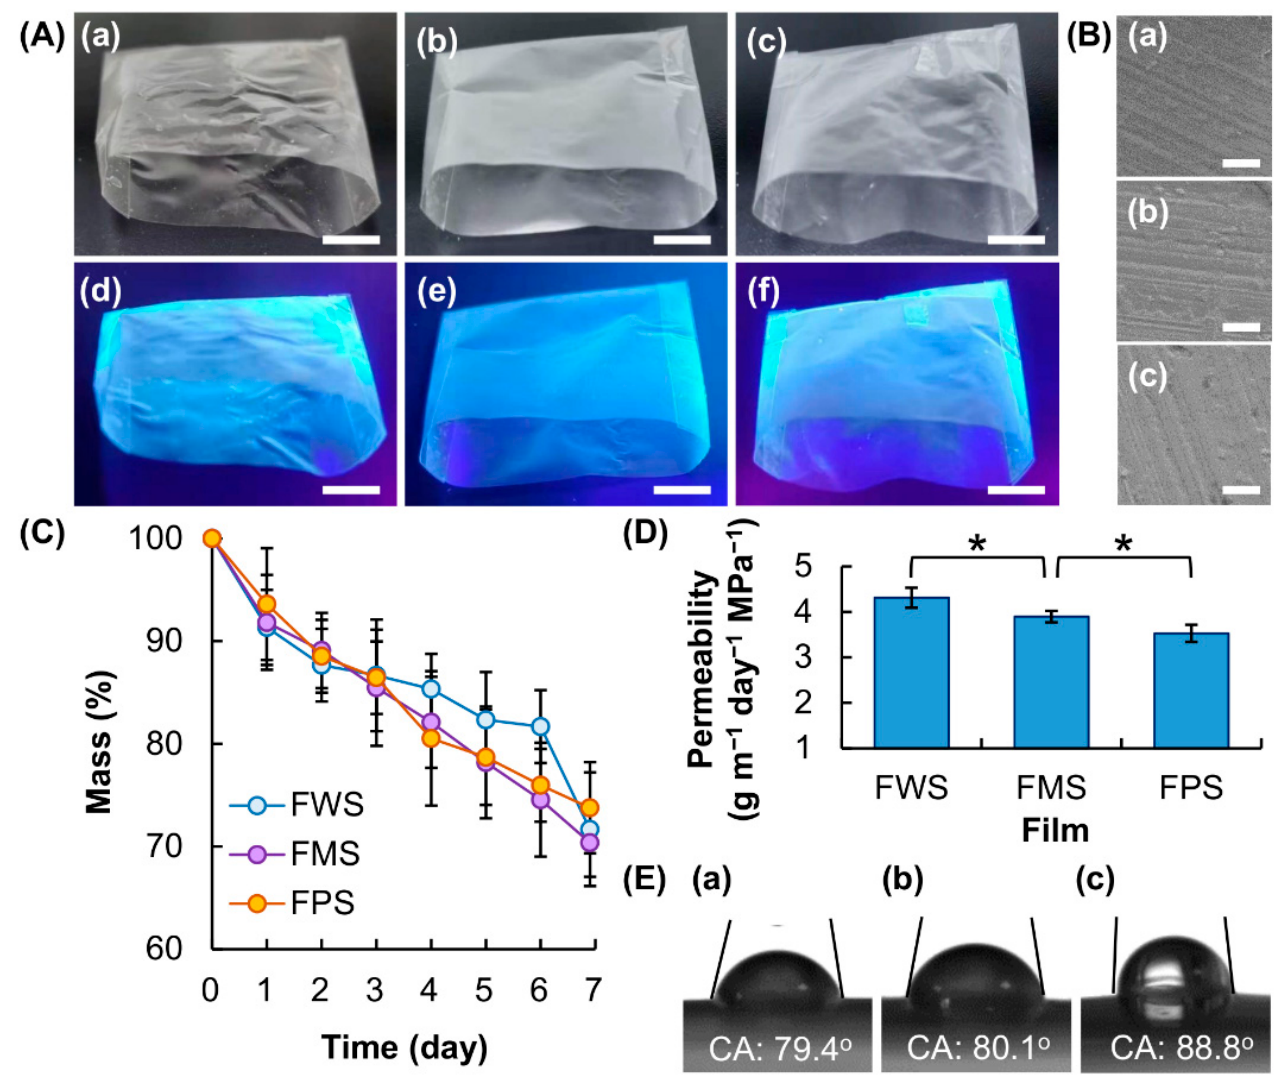
Figure 4. ( A ) Photos of packaging bags generated from ( a , d ) FWS, ( b , e ) FMS and ( c , f ) FPS under ( a – c ) white light and ( d – f ) UV light. The wavelength of UV light is at 365 nm. Scale bar = 1 cm. ( B ) Scanning electron microscopy (SEM) images of the morphology of ( a ) FWS, ( b ) FMS and ( c ) FPS. Scale bar = 10 µ m. ( C ) Erosion susceptibility and ( D ) water vapor permeability of different films. * p < 0.05. (E) Measurement of the static contact angle of a water droplet on ( a ) FWS, ( b ) FMS and ( c ) FPS.